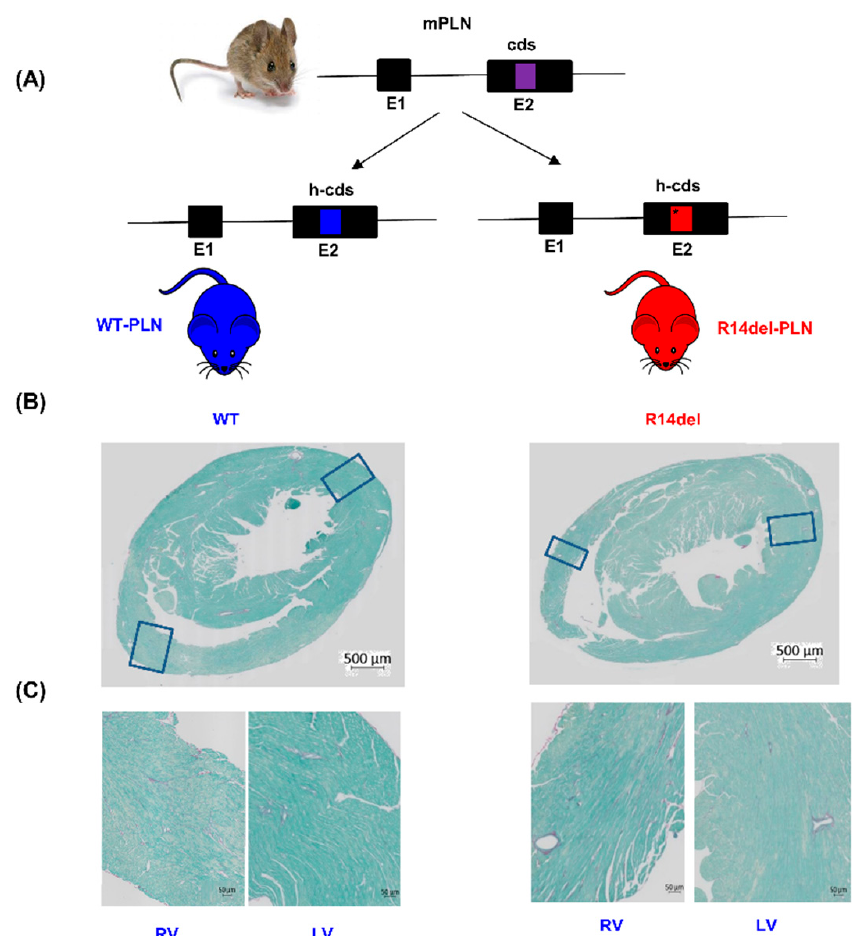
Figure 1. Generation of humanized knock-in R14del-PLN mice and cardiac histology. ( A ) Humanized wild-type (WT) and mutant (R14del) mouse models were generated by inserting the human wild-type and mutant PLN coding sequence (h-cds) into exon 2 of mouse PLN (mPLN; cds) gene-by-gene targeting methodology. ( B ) Representative cross-sections and ( C ) RV and LV sections from 3-month-old WT and R14del mice stained with Picro-Sirius Red and Fast Green solution. Magnification 20 × ; scale bar; 500 µ m and 50 µ m. N = 6 hearts for WT and N = 6 hearts for R14del.